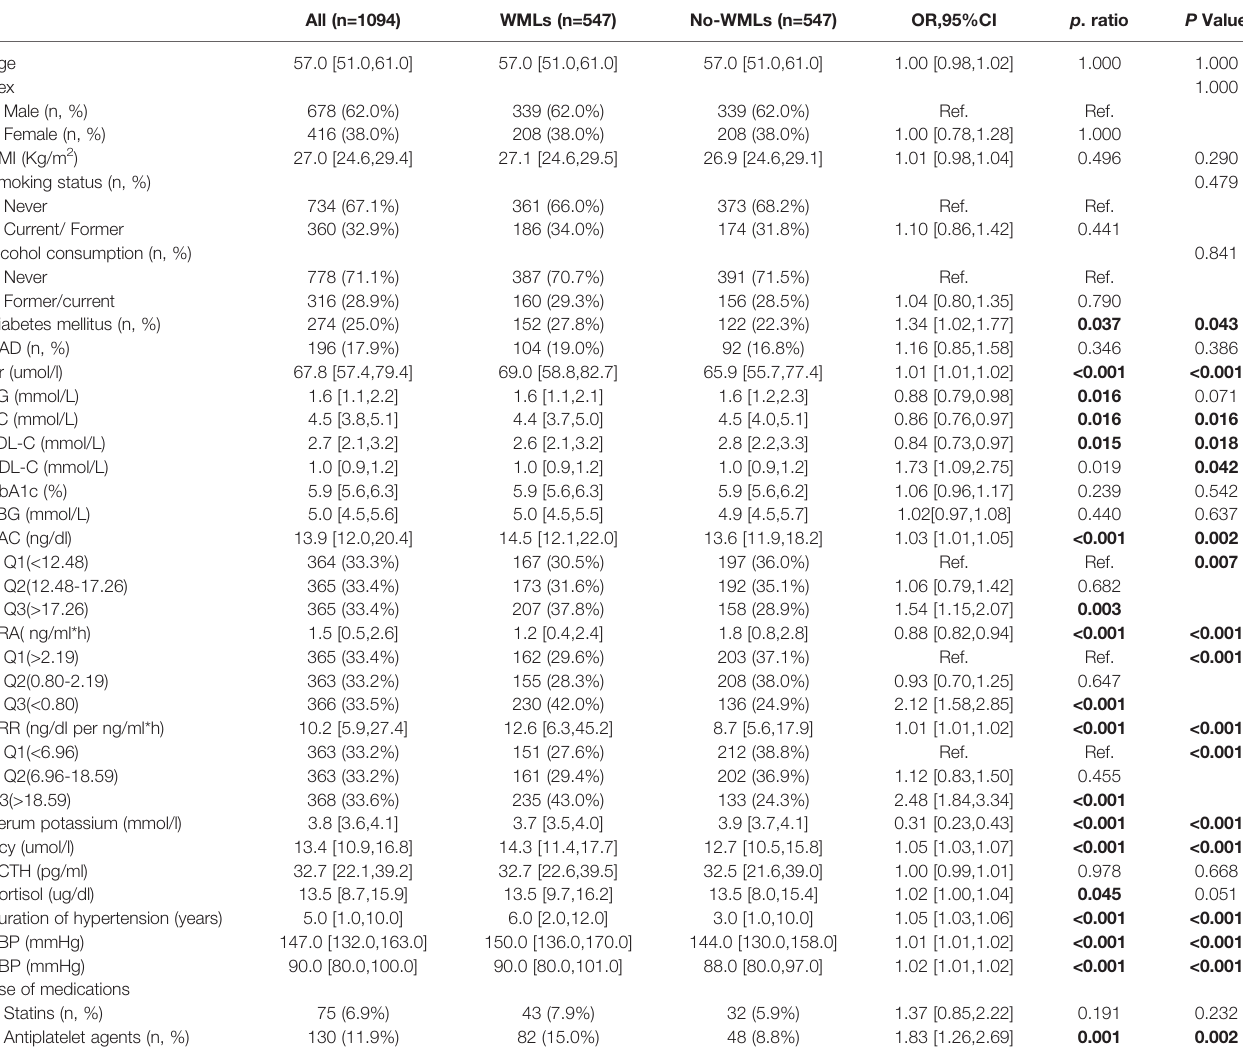
TABLE 1 | The clinical characteristic of WMLs and no-WMLs